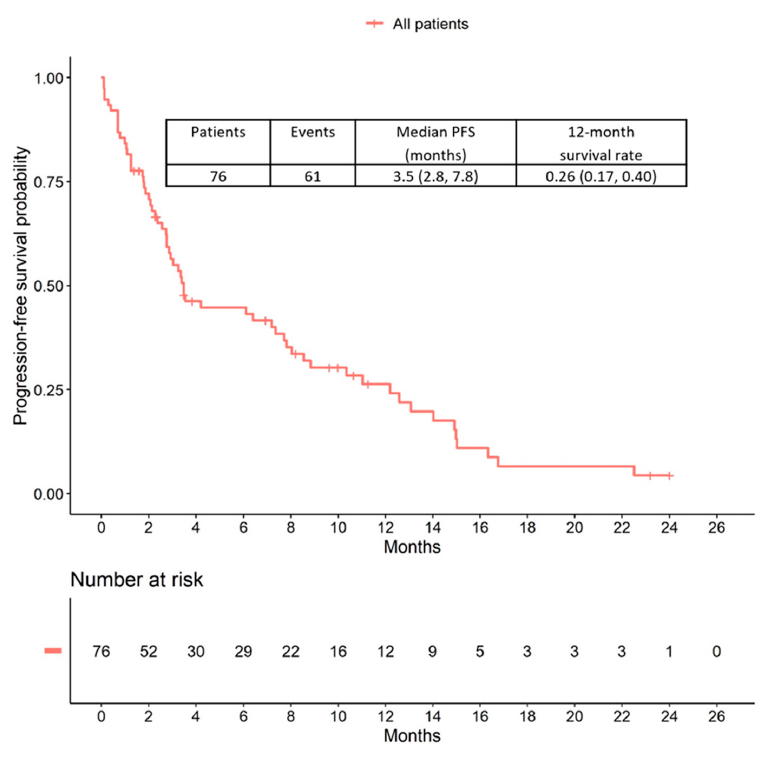
Figure 1. Progression-free survival (PFS) during treatment with T-DM1. Cancers 2020 , 12 , x